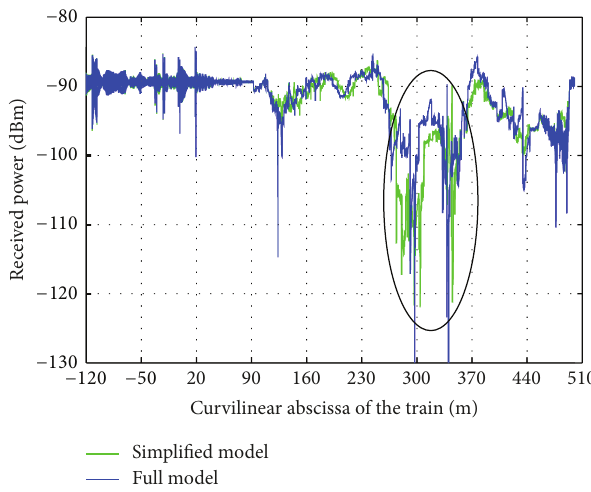
Figure 5: Evolution of the received power along the mobile train route according to the full model and the simplified